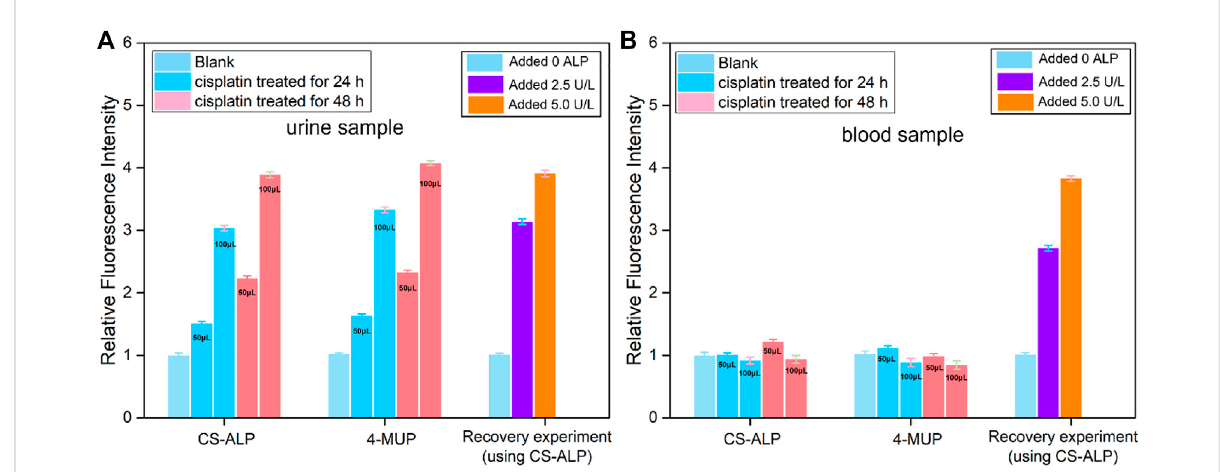
FIGURE 5 Using CS-ALP/4-MUP to test the ALP activity in urine and blood samples. The fl uorescence intensity of CS-ALP/4-MUP at 716 nm and 450 nm inmouseurinesamples (A) andbloodsamples (B) excretedbyhealthyandAKImice.Themouseurinesampleswereobtainedusingmetaboliccages, and the blood samples were obtained through retro-orbital sampling. The 50 or 100 μ L urine or blood samples were immediately added to the test solution (total volume 1 ml). Fluorescence intensity in the healthy mouse was de fi ned as